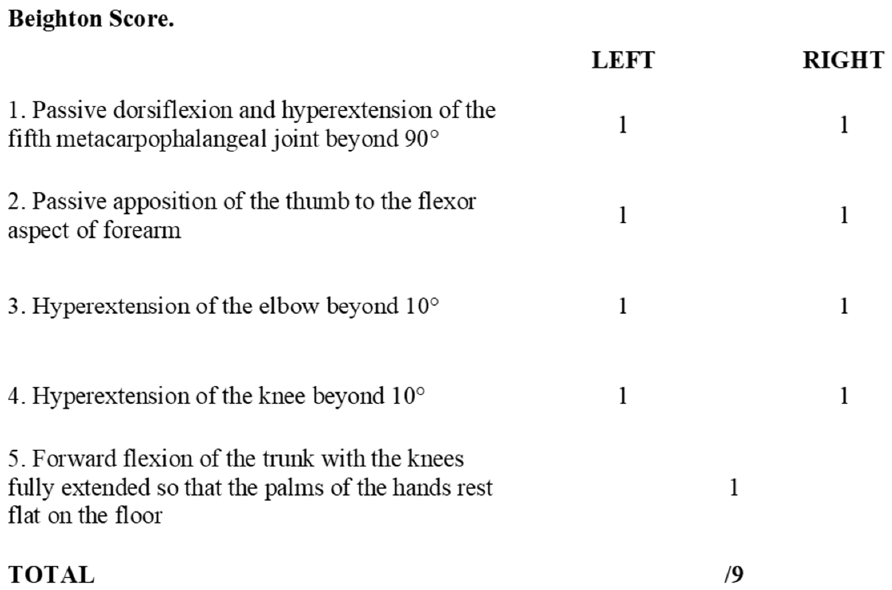
Figure 1. Beighton score. Adapted from Beighton et al., 1973 [14].